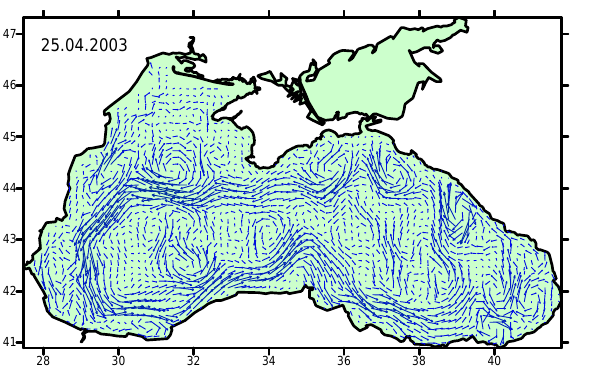
Figure 3 Surface circulation in spring season simulated by the model. Fig. 3. Surface circulation in spring season simulated by the model.